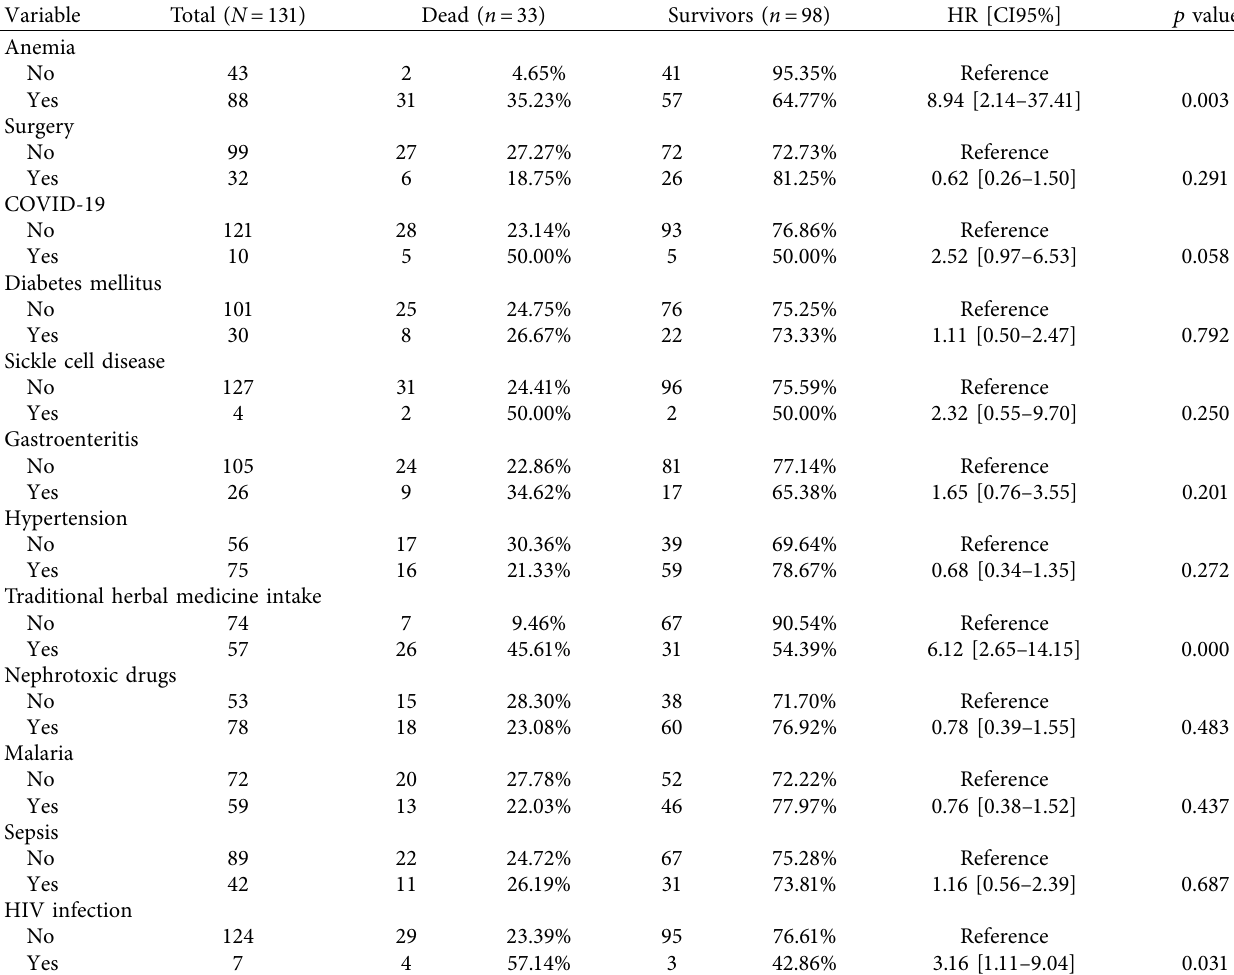
Table 2: Causes of acute kidney injury among AKI stage 3 Congolese adults admitted to the CIMAK hemodialysis centre in North-Kivu province in the DRC.